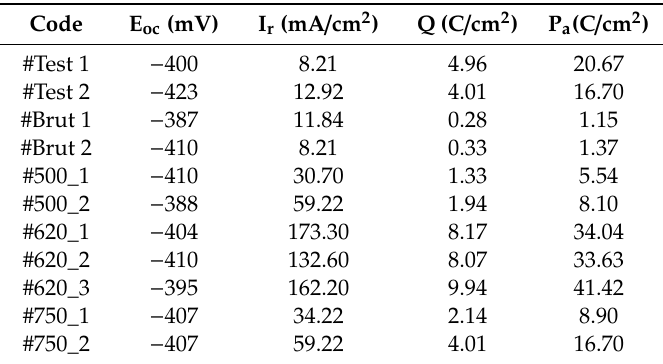
Table 10. Potentiokinetic electrochemical reactivation